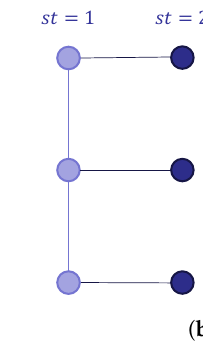
Figure 3. A scenario tree of a two-stage stochastic problem and its alternative representation accord- ing to Ruszczy´nski [35]. ( a ) Original representation of scenario tree. ( b ) Alternative representation of scenario